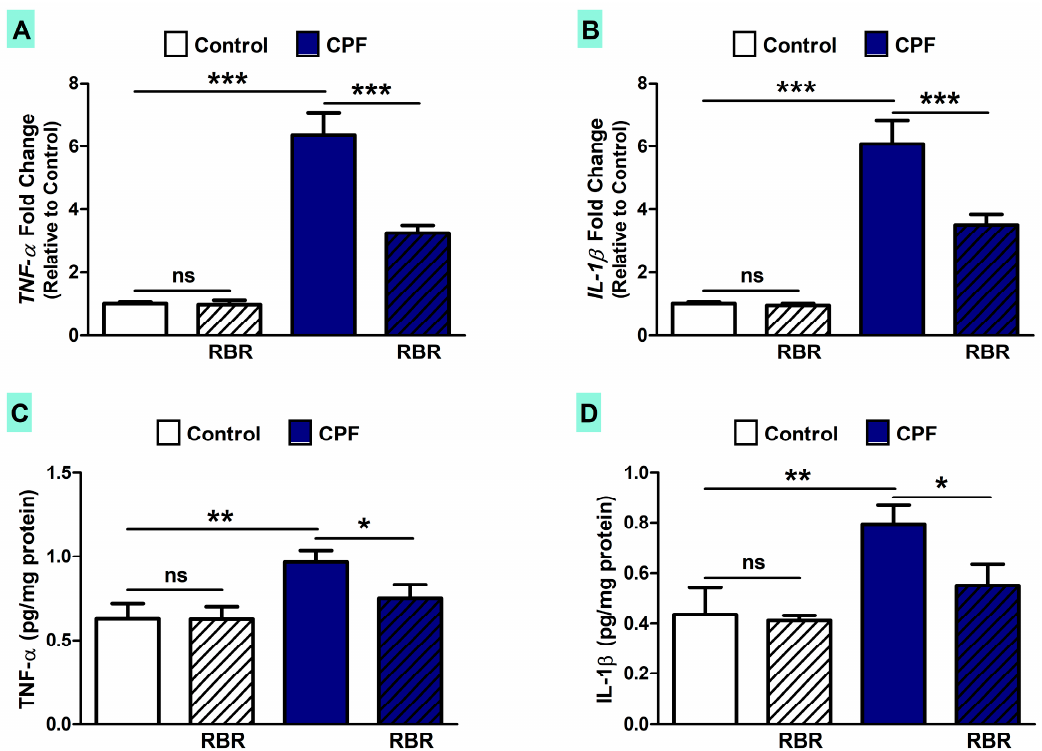
Figure 7. RBR attenuates inflammation in CPF-intoxicated rats. RBR decreases the gene ( A and B ) and protein expression ( C and D ) of TNF- α and IL-1 β in the liver of CPF-intoxicated rats. Data are mean ± SD, (N = 7). * p < 0.05, ** p < 0.01 and *** p < 0.001. ns = non-significant.